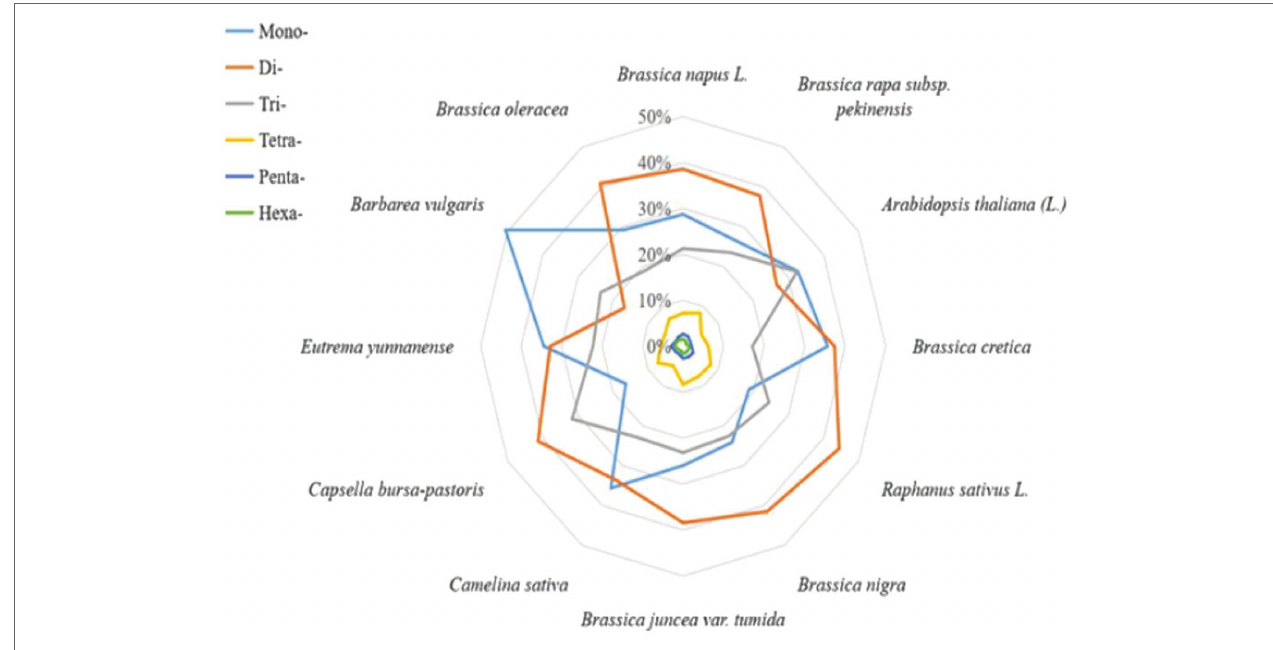
FIGURE 1 | Distribution of SSR repeated motif length across 12 cruciferous